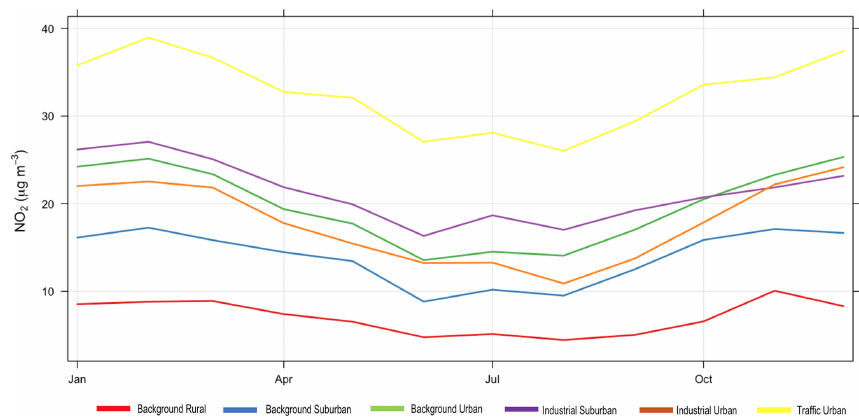
Figure 4. Monthly average concentrations of observed NO 2 for each environmental type for the year